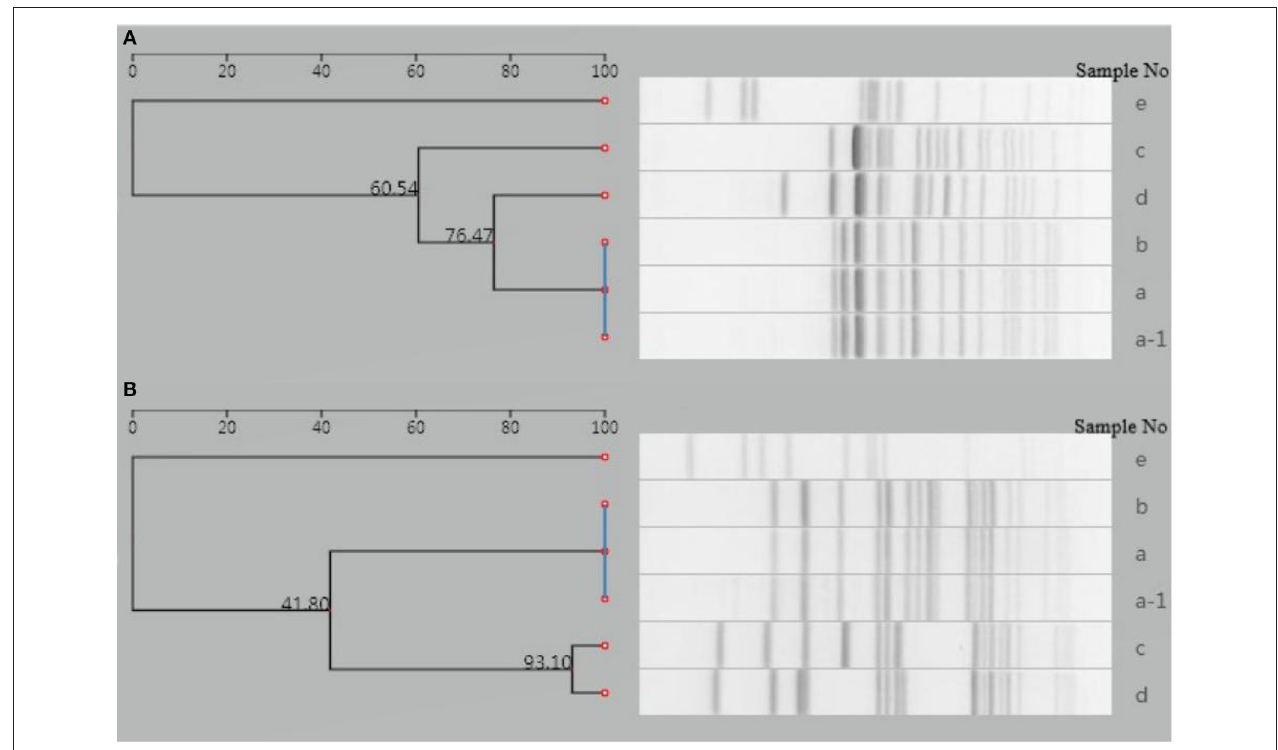
FIGURE 3 | Dendrogram of PFGE patterns for six S. Typhi isolates detected in Yantai city, China. (A) Dendrogram of Xba I-PFGE patterns. (B) Dendrogram of Bln I-PFGE patterns. a-1, a–d: Isolates from another four typhoid outbreaks in the same period (within 2 months); e: isolate from the case presented in this study.